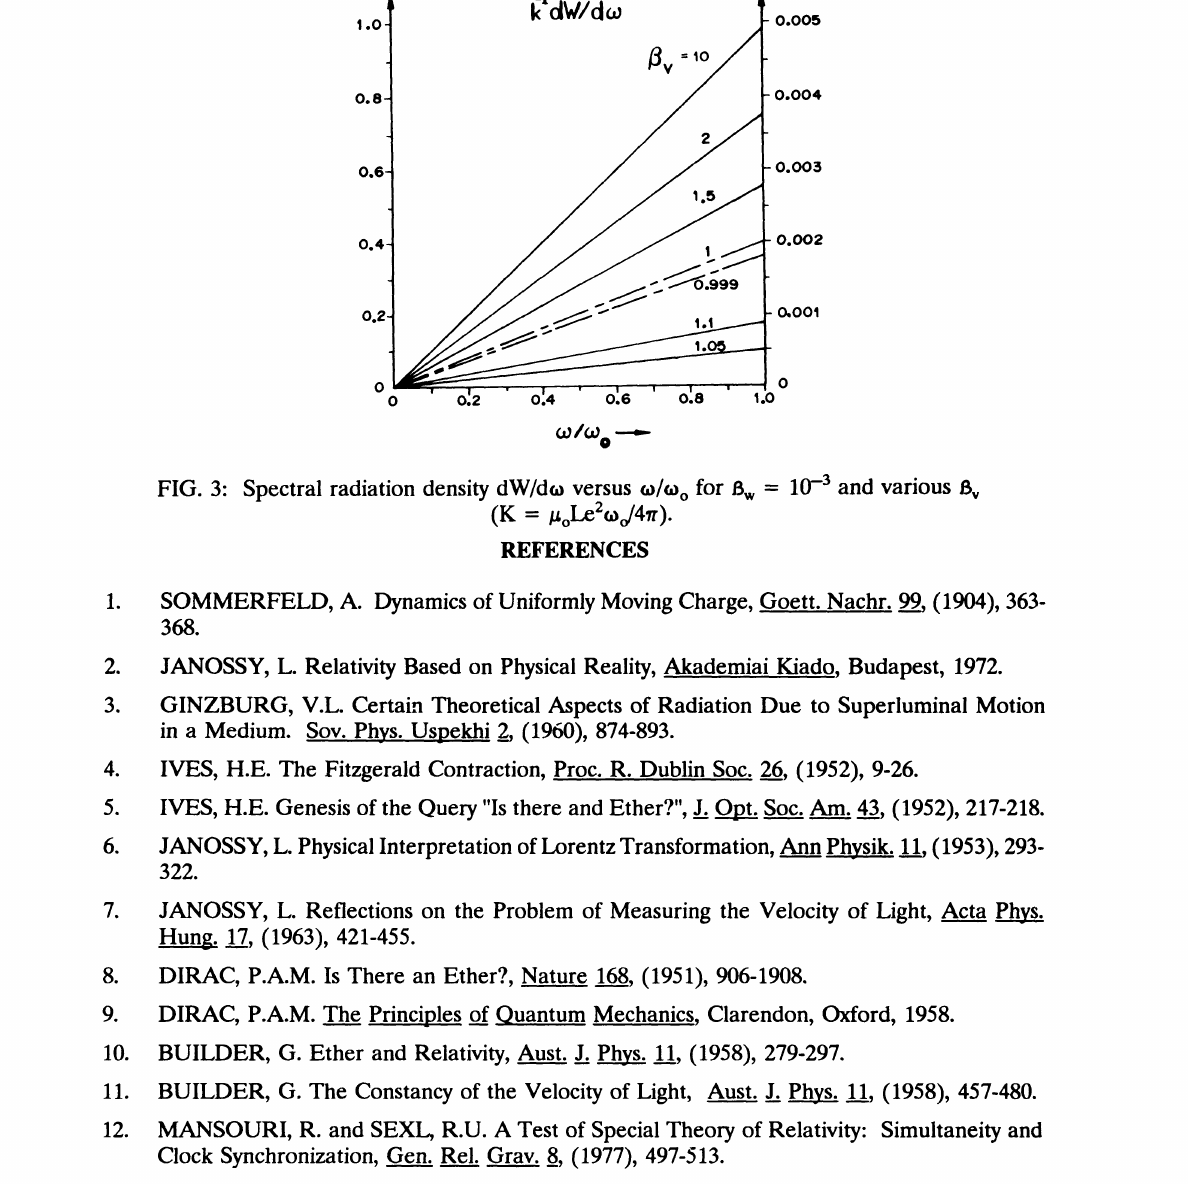
FIG. 2: Wave fronts of EM shock wave in substratum, with moving charge e at vertex of Mach cone.